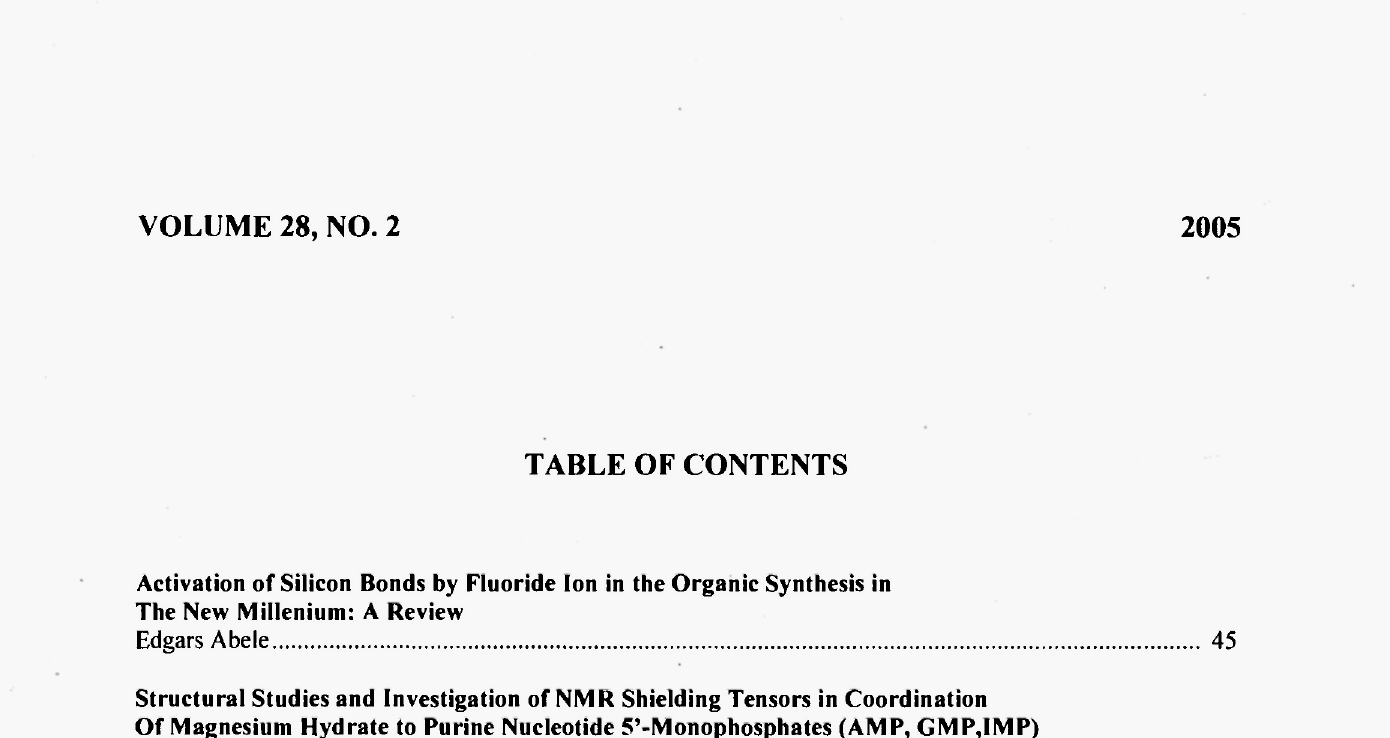
Sb-C Bond Cleavage Reaction